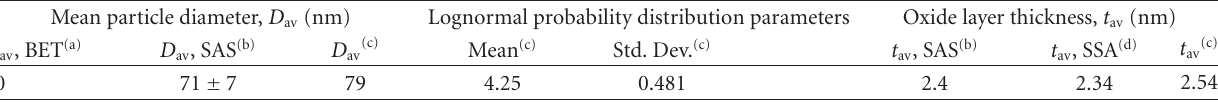
Table 1: Properties of 80 nm aluminum powder (Novacentrix Inc., product no. M2666).